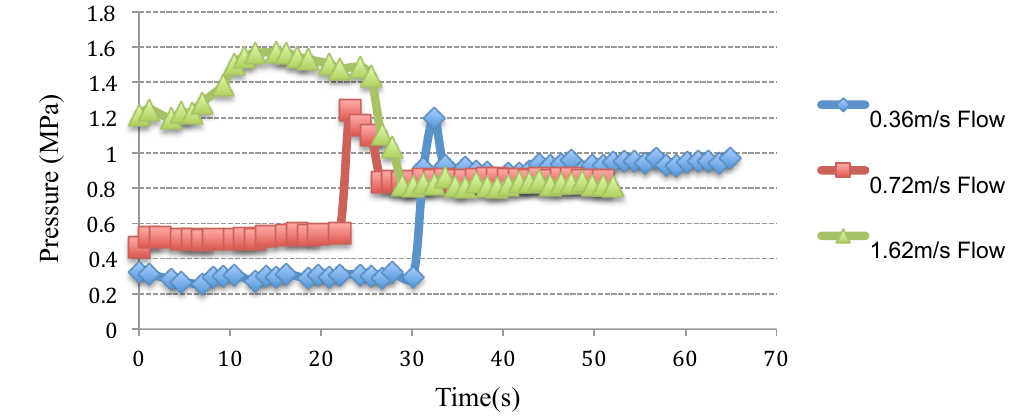
Figure 14. The ERF valve’s closing effect on the pressure drop is shown for different initial flow rate